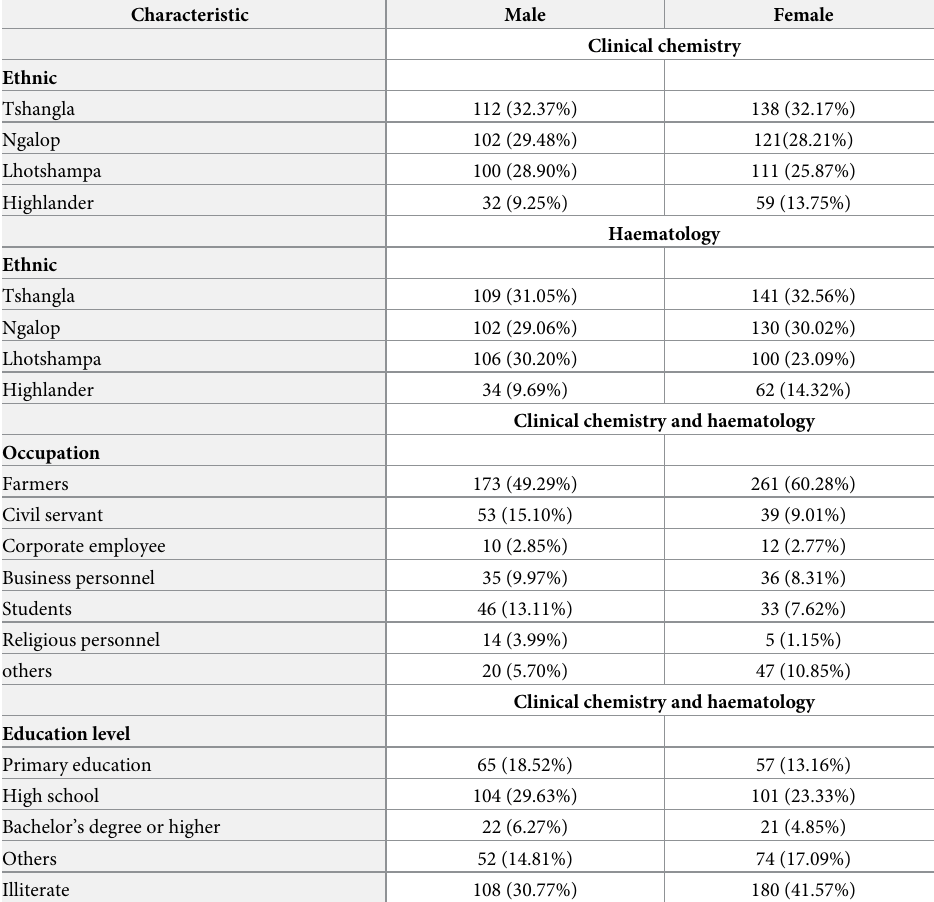
Table 3. The demographic details (ethnic distribution, education level and occupation) of the clinical chemistry and haematology reference sample group.